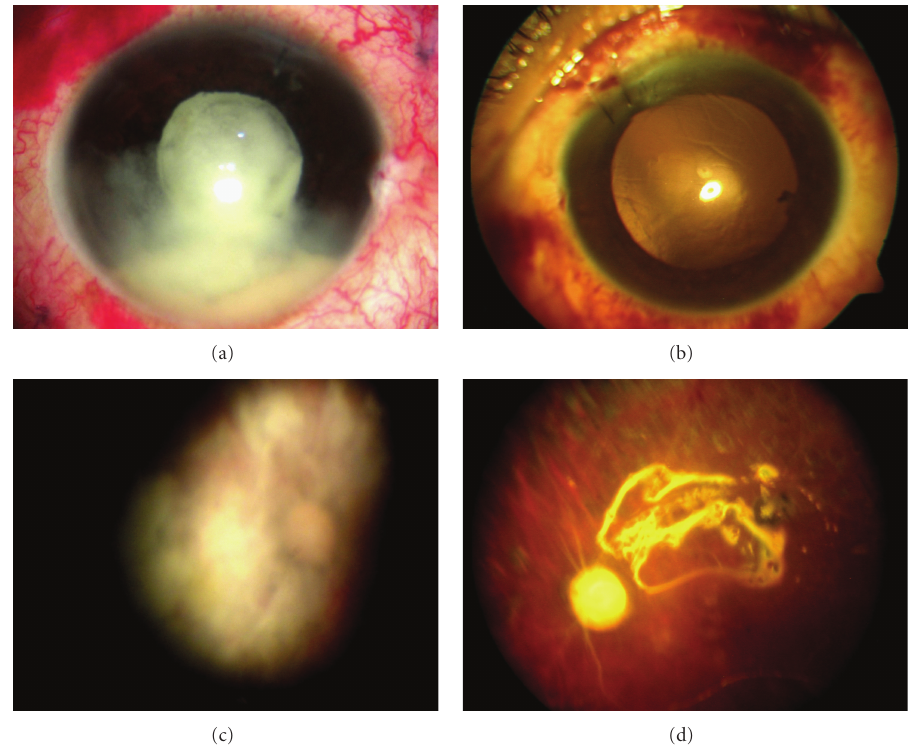
Figure 2: Patient’s clinical evolution: ((a) and (c)) previous air-fluid interchange and intravitreal ampicillin sodium; the anterior segment biomicroscopy showed severe conjunctival hyperemia, severe cellularity, and Hypopyon with a fibrin clot on the surface of the intraocular lens. The details of the retina cannot be observed due to significant posterior opacities. However, the optic nerve seems to be extremely pale with severe attenuation of the blood vessels. ((b) and (d)) Four weeks after second surgery; anterior segment biomicroscopy showed an improvement in conjunctival hyperemia (mild), with disappearance of Hypopyon and fibrin cloth, and the retina showed extensive areas of photocoagulation (first surgery), severe pallor of the optic nerve, bloodless vessels, and vitreous cavity filled with silicon